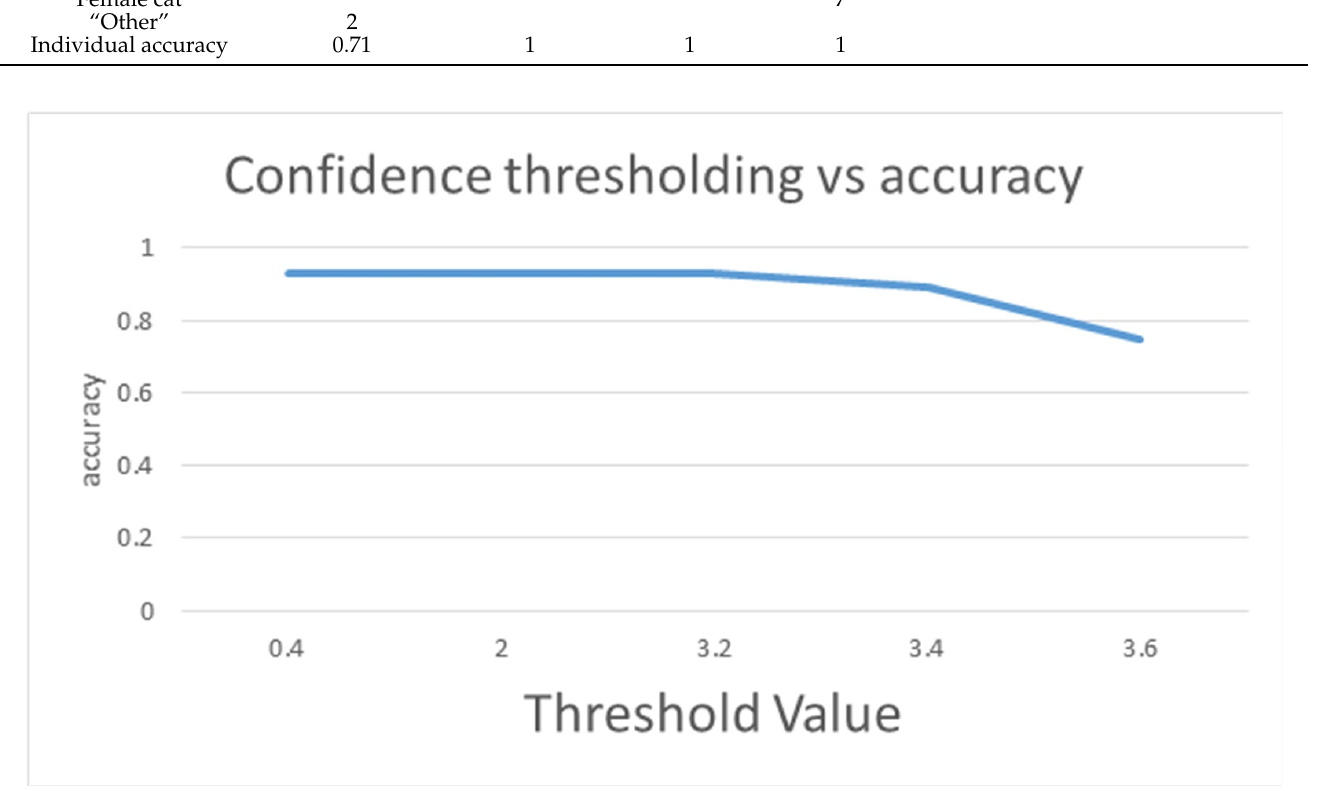
Figure 18. Confidence thresholding vs. accuracy by Yolov4 under the balanced data set.